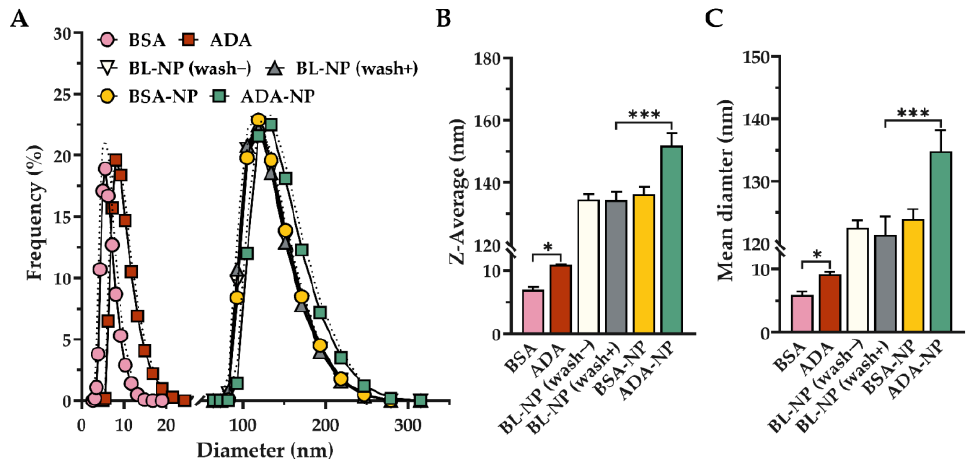
Figure 1. Physicochemical nanoparticle properties analyzed by PCS. ( A ) Particle size distribution curve of bovine serum albumin (BSA) or adalimumab (ADA) solution and BSA- or ADA conjugated nanoparticles (BSA-NP, ADA-NP). Data are shown as mean (solid lines) ± SD (dotted lines) for n = 10 measurements. ( B ) Z-Average and ( C ) Mean diameter of BSA- or ADA-solution and BSA- or ADA-NP. Data are shown as mean ± SD ( n = 10). Statistical significance was assessed by one-way ANOVA followed by Tukey’s multiple comparisons test (* p < 0.05, *** p < 0.001).